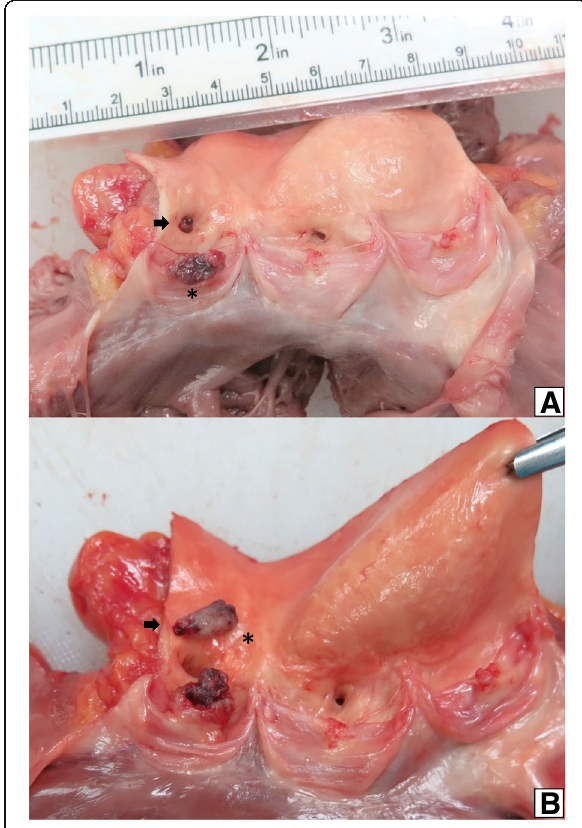
Fig. 1 a Vegetation on the left aortic cusps (asterisk) with emboli (arrow) in the left coronary ostia. b Showing emboli after removal (arrow) from the left main coronary artery. Also note the eroded aortic valve